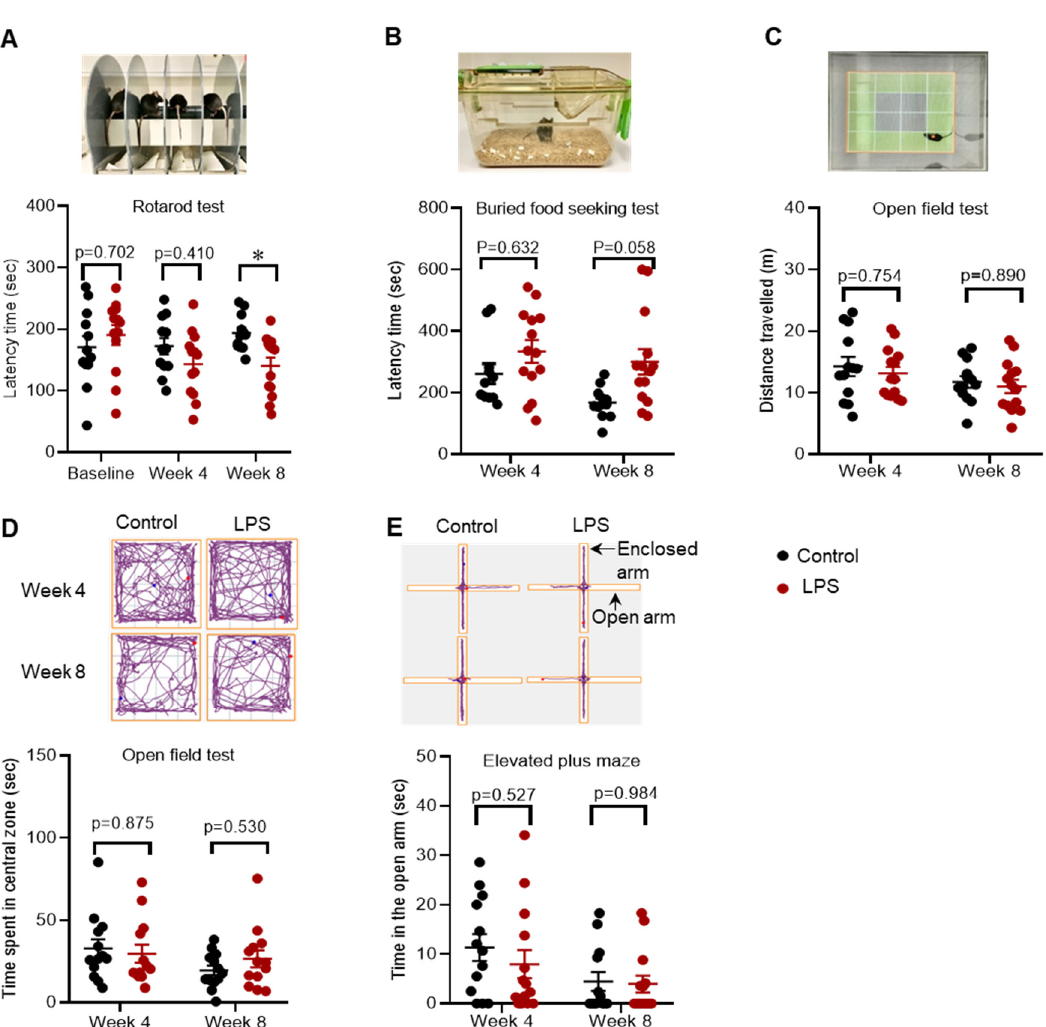
Figure 1. Administration of LPS into the striatum induced motor impairment, but not olfactory dysfunction or anxiety-like behaviour in C57BL/6 mice. ( A ) Set up and latency time in the rotarod test. ( B ) Set up and latency time in the buried food-seeking test. ( C ) Setup and distance travelled in the open field test. ( D ) Computerized tracing of the mice in the open field and time spent in the central zone of the open field. ( E ) Computerized tracing of the mice in the elevated plus-maze and time spent in the open arm. The results are presented as mean ± SEM (control n = 12–13; LPS n = 13–14). Statistical analysis was performed with a two-way ANOVA test, p < 0.05 (*).